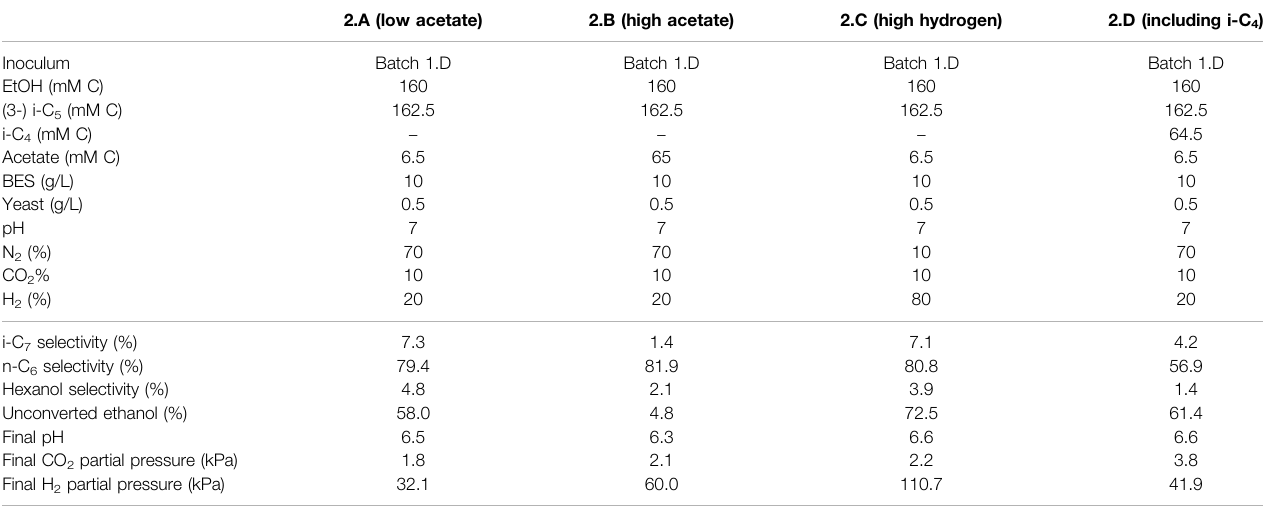
TABLE 3 | Overview of the different starting parameters (t (cid:2) 0) for the second batch series, as well as fi nal values (t (cid:2) end) for product selectivites (% of total formed